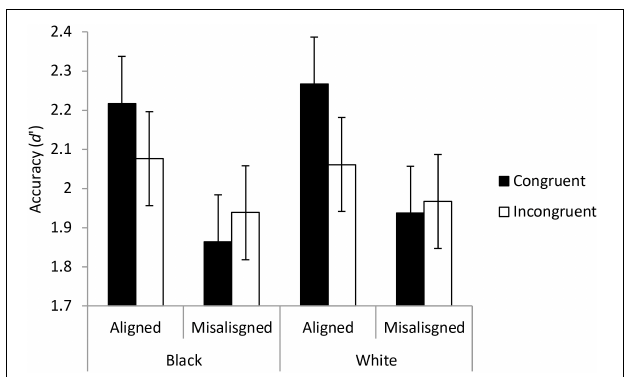
FIGURE 6 | The results of Experiment 1 displayed to illustrate the complete design or the congruence design. The points show the means of the discrimination measures from the signal detection analyses for each participant based on correctly identifying that the tops of the images were the same. The error bars show ± one standard error. A higher accuracy score represented better overall performance for detecting differences and determining when the eyes were the